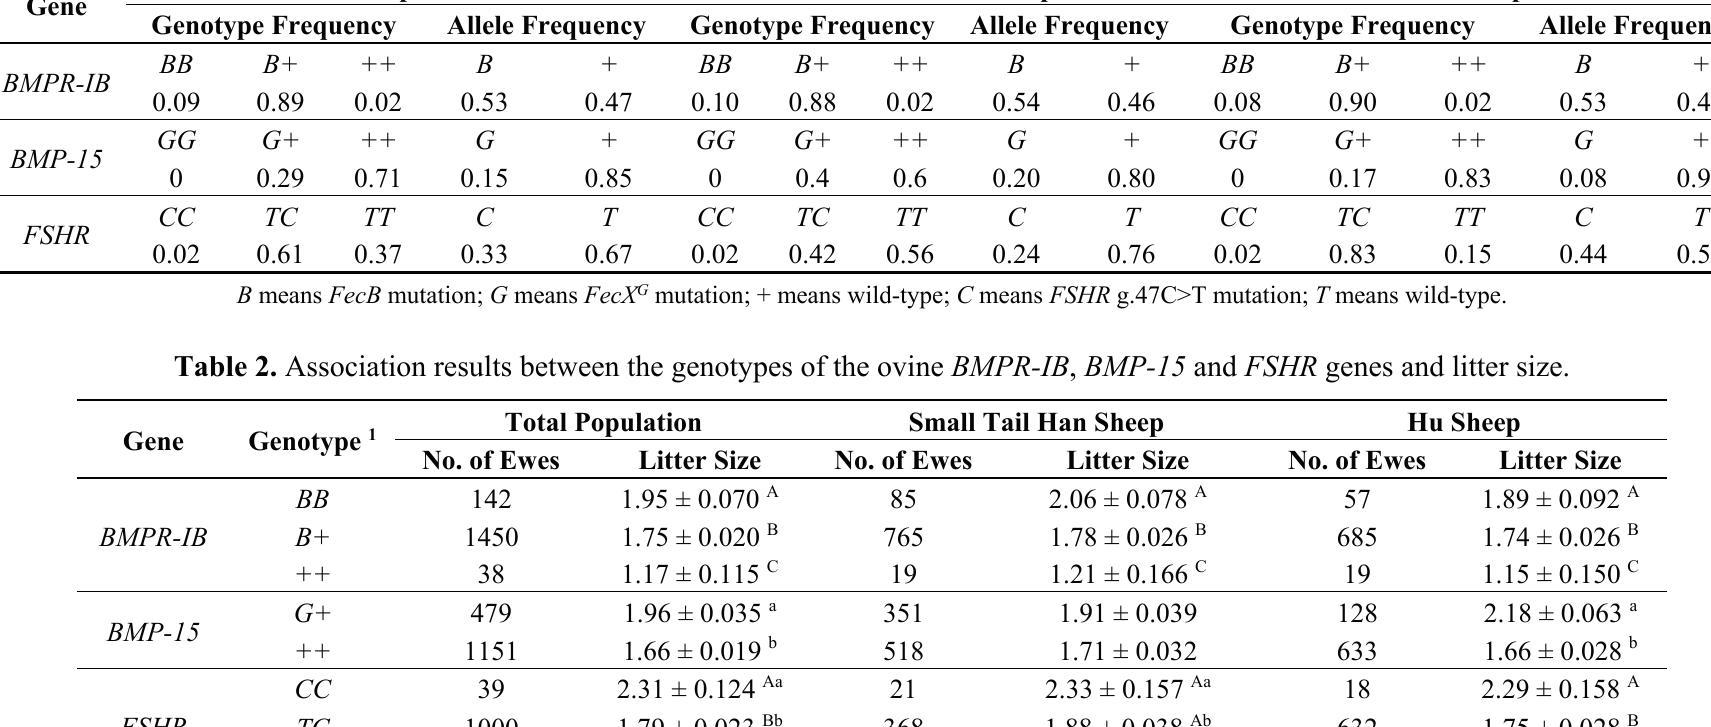
Table 1. Allele and genotype frequencies of the ovine BMPR-IB , BMP-15 and FSHR genes in experimental populations. Gene